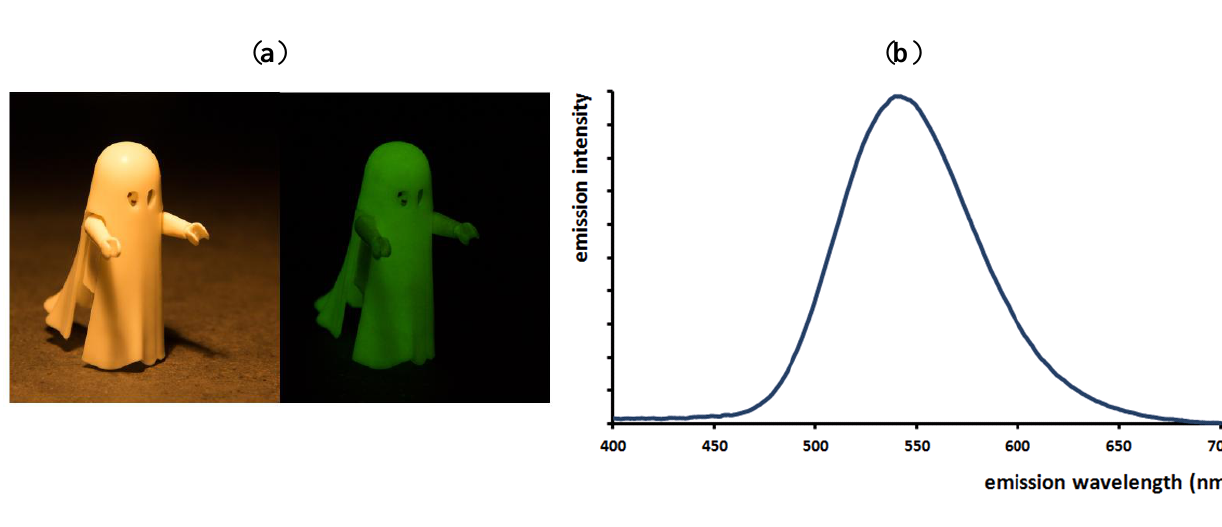
Figure 2. ( a ) Green persistent luminescence in a Playmobil ® ghost toy based on ZnS:Cu, Co. ( b ) Afterglow emission spectrum of ZnS:Cu, Co centered around 540